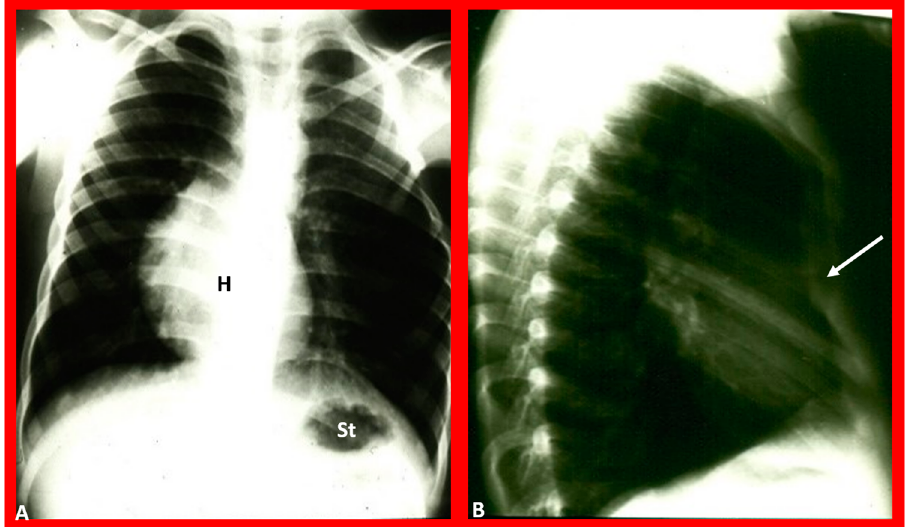
Figure 12. Chest X-rays of a five-year-old patient who was seen for evaluation since the referring physician noted a right-sided heart. Physical examination was unremarkable. ( A ) The heart (H) is displaced to the right, and there was no obvious pulmonary pathology. The gaseous shadow of the stomach (St) is located on the left side (normal). ( B ) The sternum (arrow) is showing posterior displacement, presumably causing dextroposition of the heart. Modified from reference